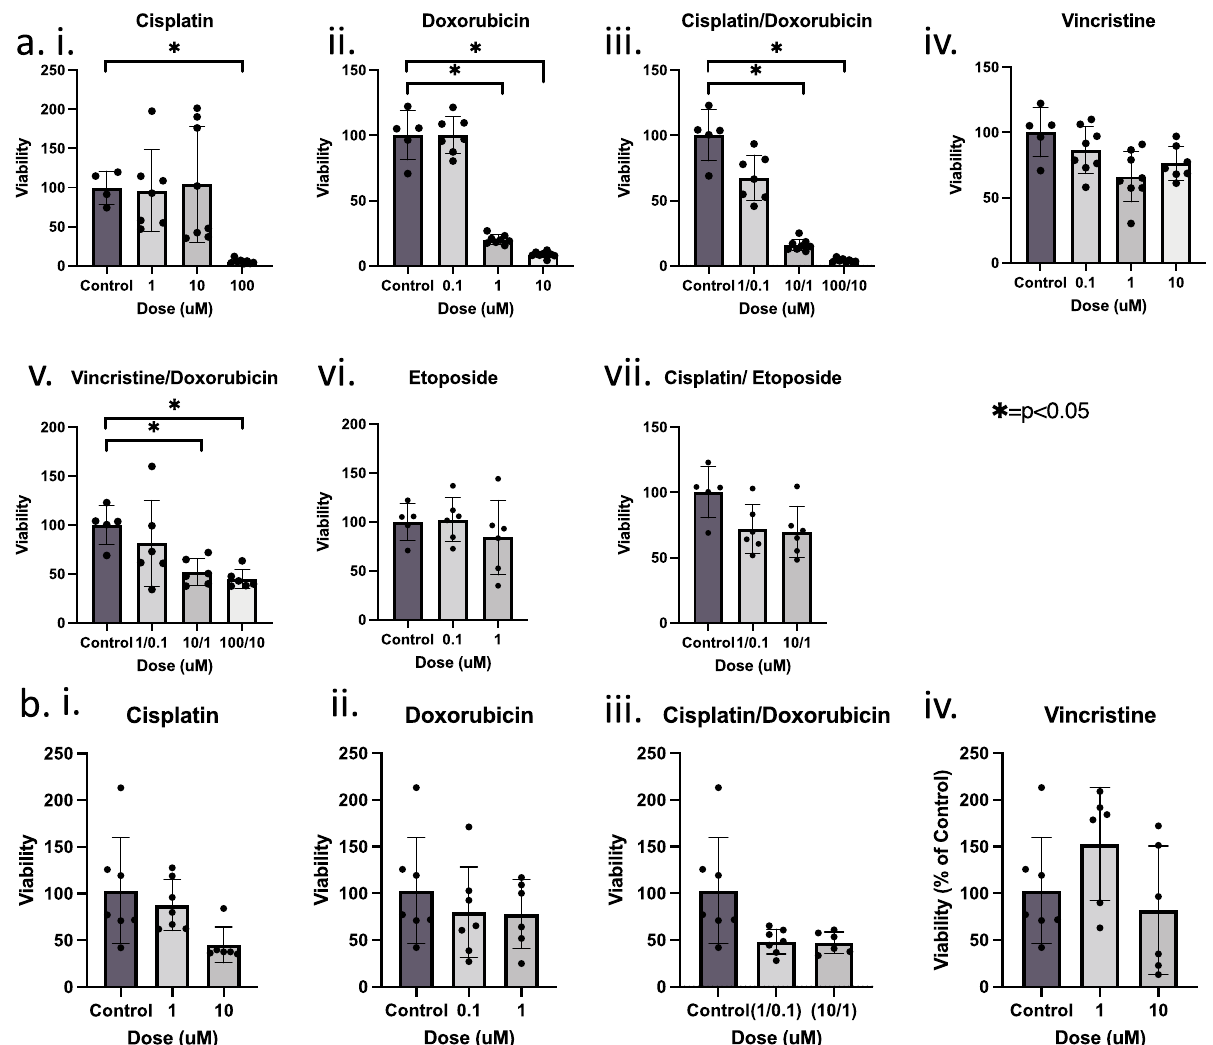
Figure 4. Application of personalized chemotherapy treatment platform for ( a ) MCC2 and ( b ) MCC5 with (i) Cisplatin. (ii) Doxorubicin. (iii) Vincristine. (iv) Etoposide. (v) Cisplatin/Doxorubicin. (vi) Cisplatin/Etoposide and (vii) Vincristine/Doxorubicin. Summary of CellTiter-Glo 3D assay results for ( a ) MCC2 demonstrate dose-dependent treatment responses for (i) Cisplatin (ii) Doxorubicin (iii) Cisplatin/Doxorubicin and (vii) Vincristine/Doxorubicin while ( b ) MCC5 illustrated these results for (i) cisplatin and (iii) cisplatin/doxorubicin. Under each dose, replicates listed as data points. *p <